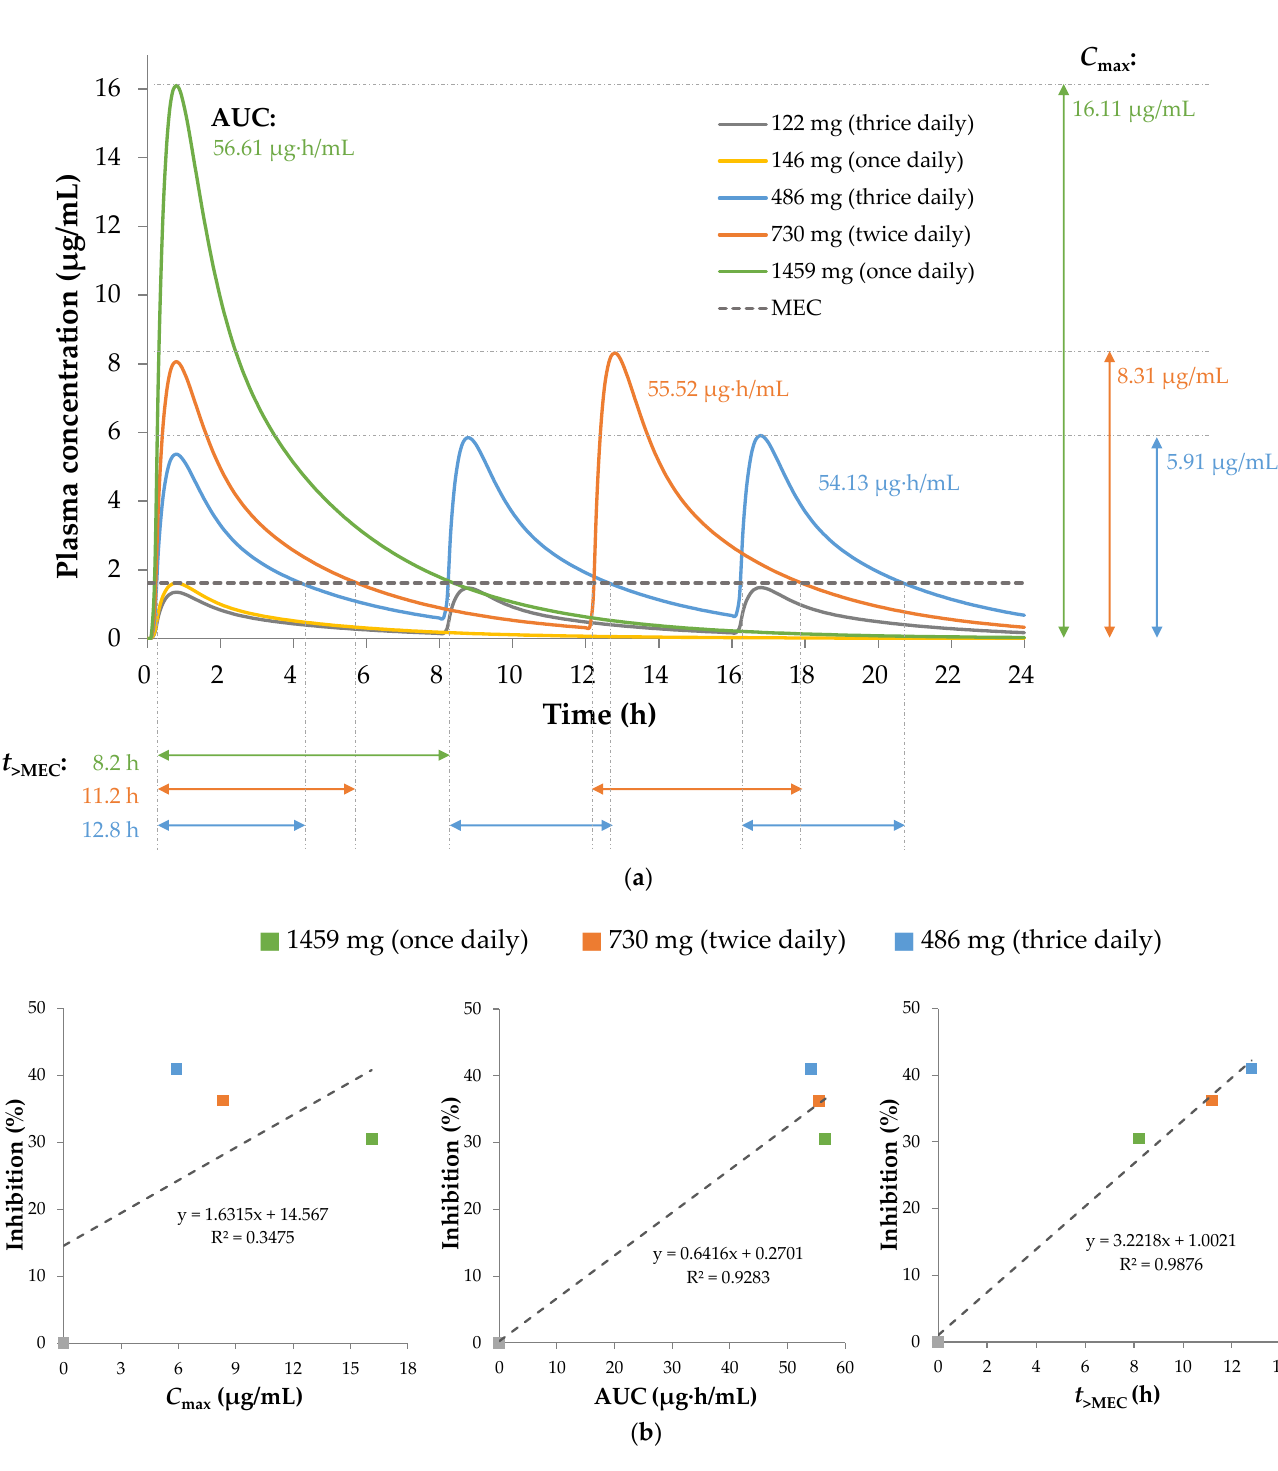
Figure 5. ( a ) Simulation for oral pharmacokinetic profiles of sobrerol with the minimum effective concentration (MEC) of 1.61 μ g/mL, and calculation for pharmacokinetic efficacy indexes ( C max , AUC, and t >MEC ) of administration routes with total daily dose of 1459 mg during 24 h. ( b ) Linear regression of each pharmacokinetic efficacy index versus the inhibition rate, showing that time dependence is responsible for the pharmacokinetics/pharmacodynamics correlation of sobrerol.